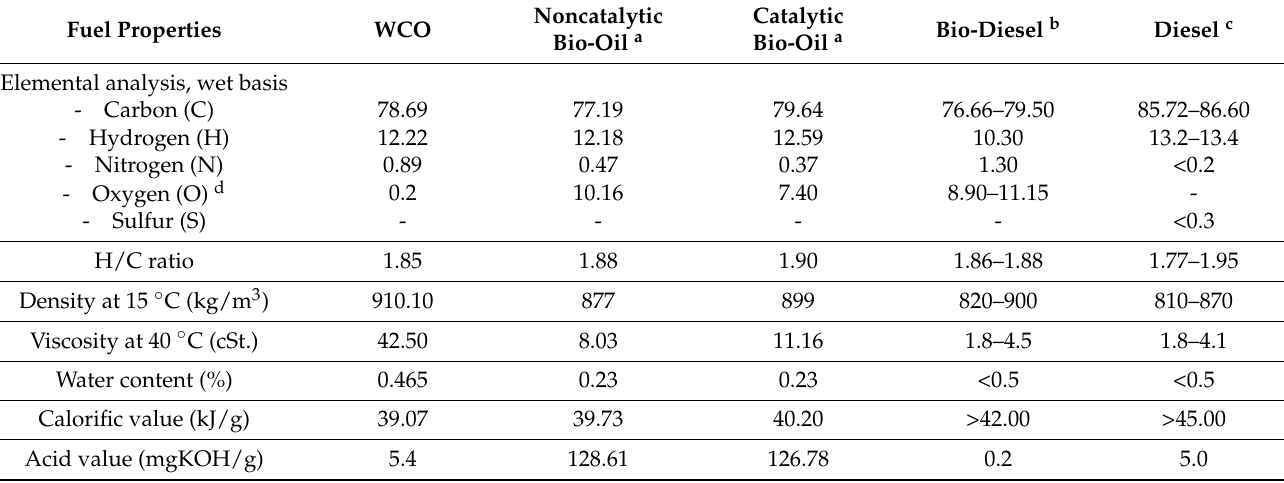
Table 5. The fuel properties of WCO, liquid bio-oil, diesel and